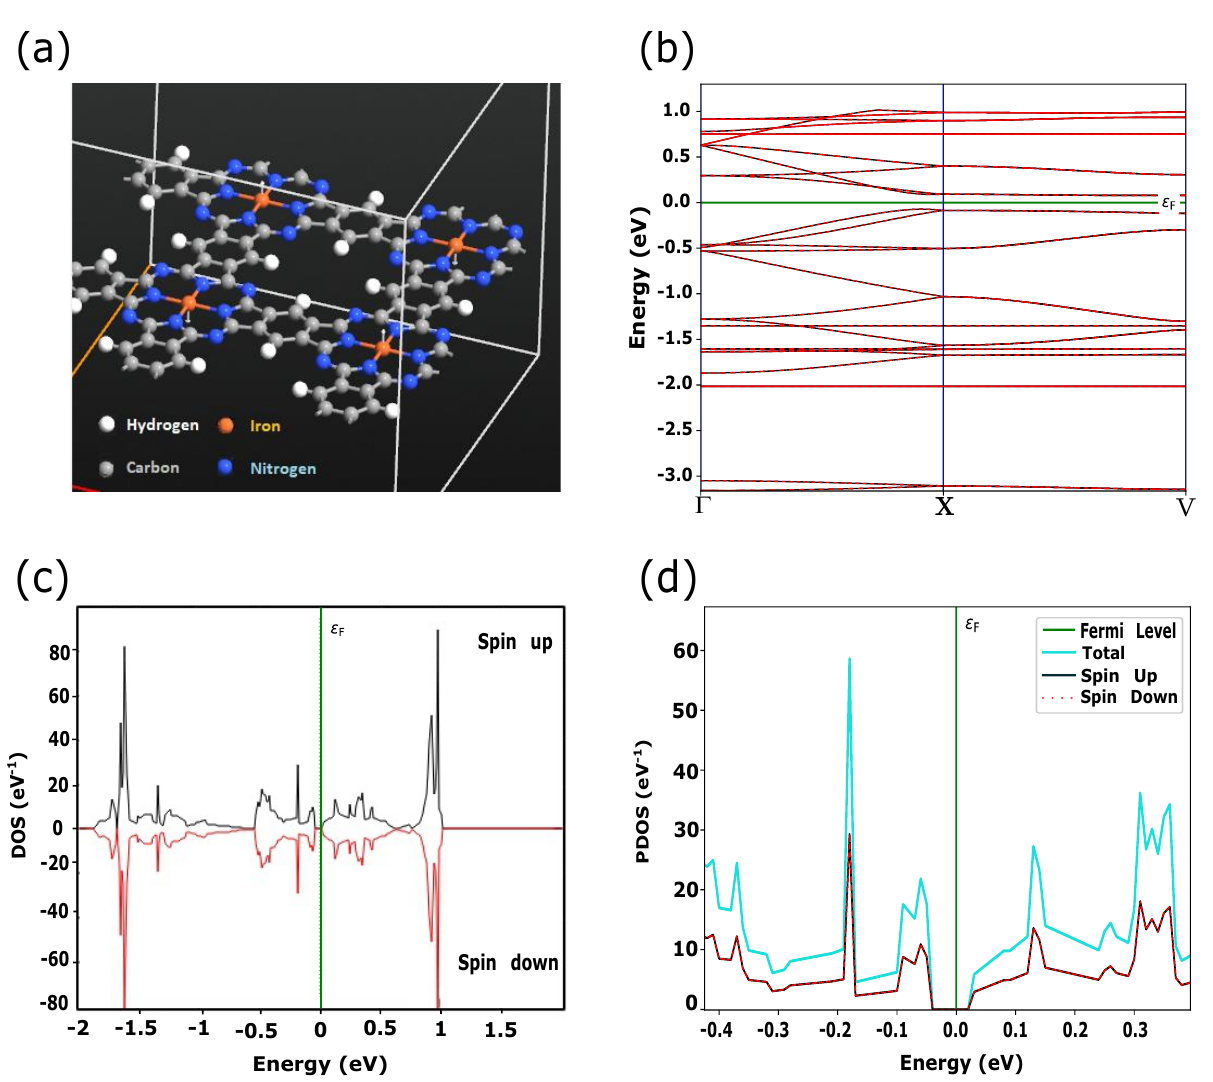
Figure 2. ( a ) FePPC with magnetic moments (white arrows) aligned in an anti-parallel configuration, defined as AFM ordered; ( b ) Dispersion bands, showing an indirect band gap along Γ -X-V symmetry points in k -space (in-plane PPC direction in real space); ( c , d ) DOS and PDOS, depicting the related band gap. Spin up and spin down components of electronic states are symmetrically